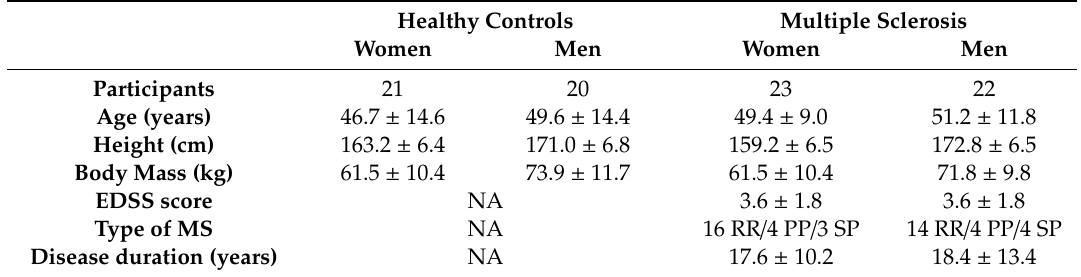
Table 1. Anthropometric and clinical features of participants. Values are expressed as mean ± SD. Healthy Controls Multiple Sclerosis Women